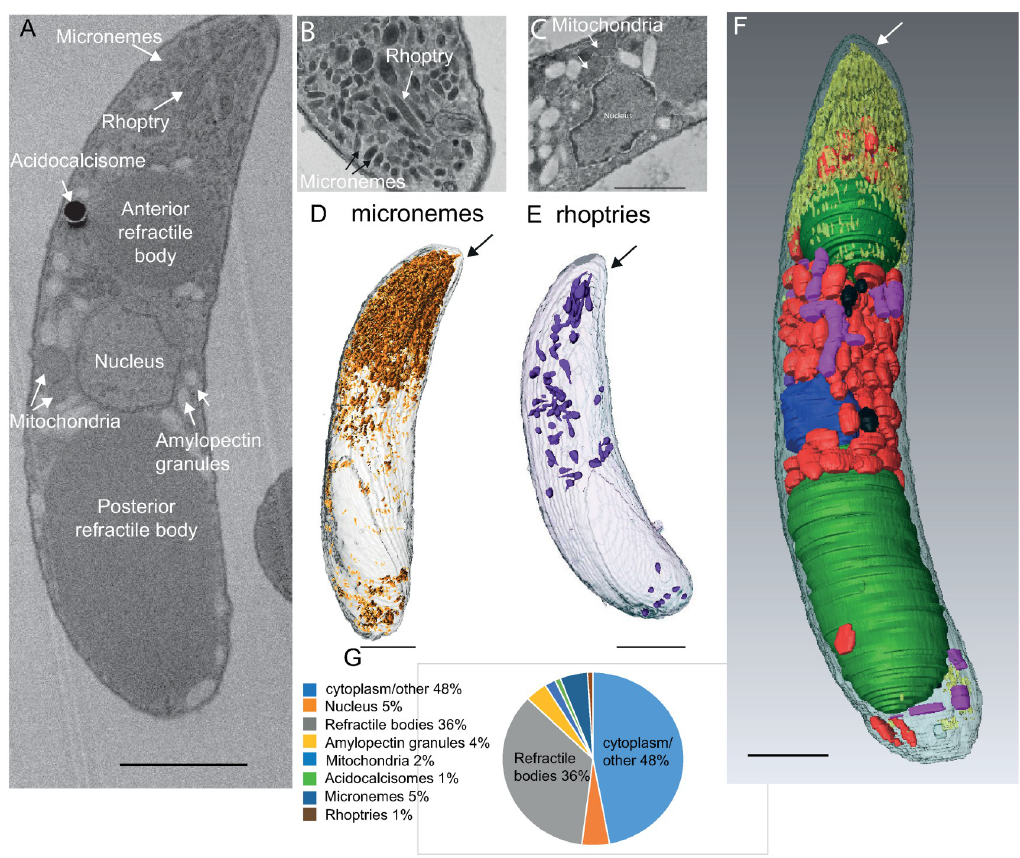
Fig 4. SBF-SEM quantification of micronemes, rhoptries and other major organelles in freshly excysted sporozoites. A: Longitudinal section slice from an SBF-SEM dataset illustrating the major organelles. B and C: Thin section TEM images to illustrate identification of major organelles. D and E: Quantification and location of microneme and rhoptry organelles in SBF-SEM whole cell reconstructions. F. Combined segmentation illustrating the positioning of all the major organelles: micronemes–yellow, refractile bodies–green, amylopectin granules–red, acidocalcisomes–black, rhoptries–purple, nucleus–blue— Scale bars– 1 μ m;G. Relative volumes of major organelles in freshly excysted